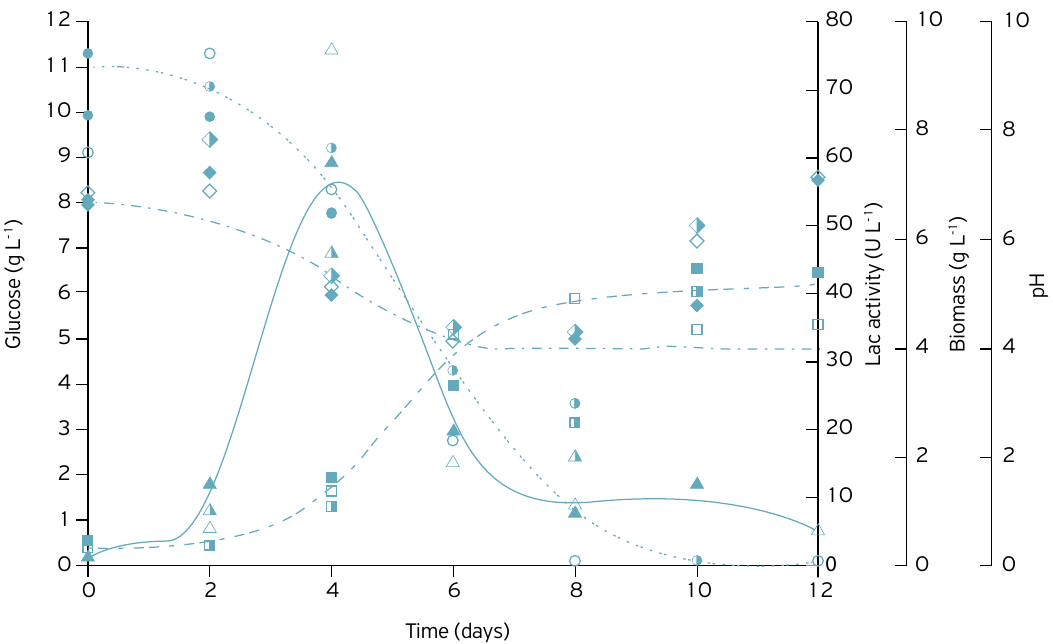
Figure 1. Profiles of biomass growth (dashed line, -  -, -  -), glucose consumption (dotted line, -  -, -  -), laccase activity (continuous line, - -, - -) and pH (dash dot line, - -, - -) with time (days), in the absence of Tween 80. The open and closed symbols represent data from